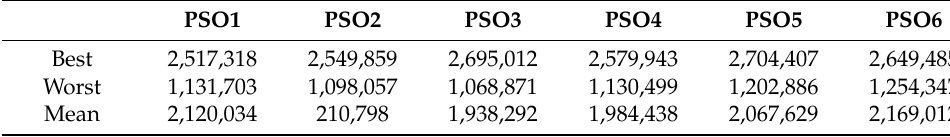
Table 5. The best, worst, and mean results of